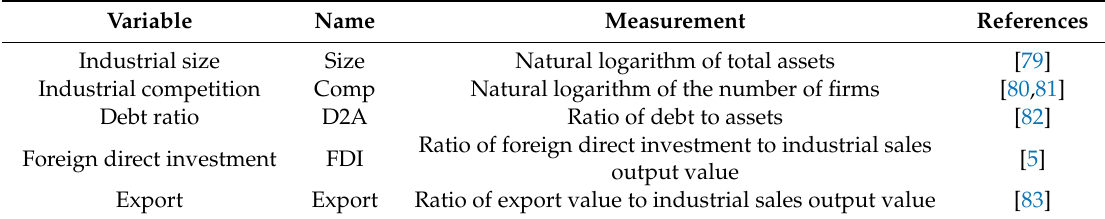
Table 3. The details of control variables.